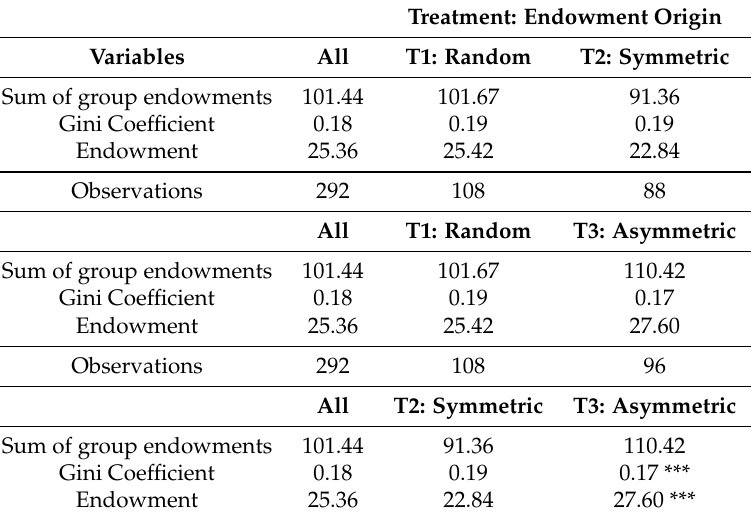
Table 3. Descriptive Statistics: Experimental